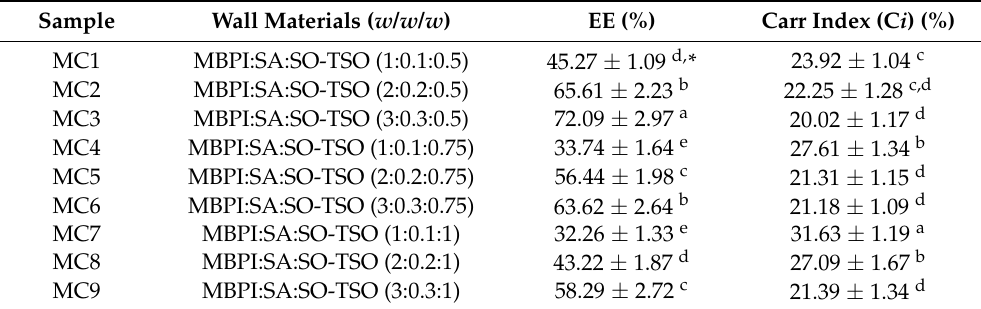
Table 1. Encapsulation efficiency (EE) and Carr index (C i ) of SO-TSO encapsulated using MBPI and SA at varied